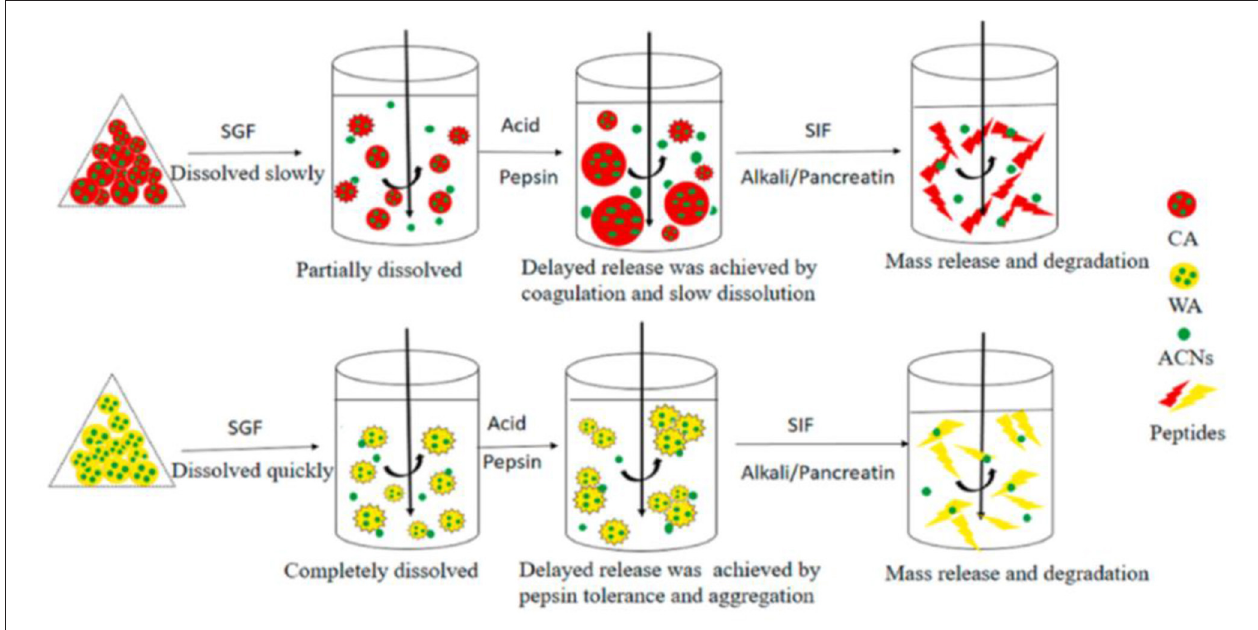
FIGURE 3 | Release mechanisms of CA-ACN and WA-ACN microparticles during in vitro digestion. Reproduced from reference (36) with permission. CA, casein; WA, Whey protein isolate; ACN, anthocyanin; SGF, simulated gastric fluid; SIF, simulated intestinal fluid.